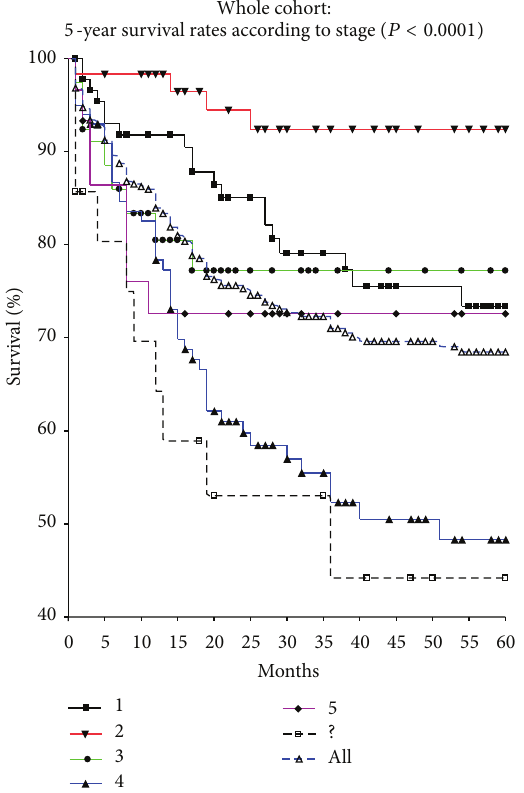
Figure 1: Whole cohort: 5-year survival according to